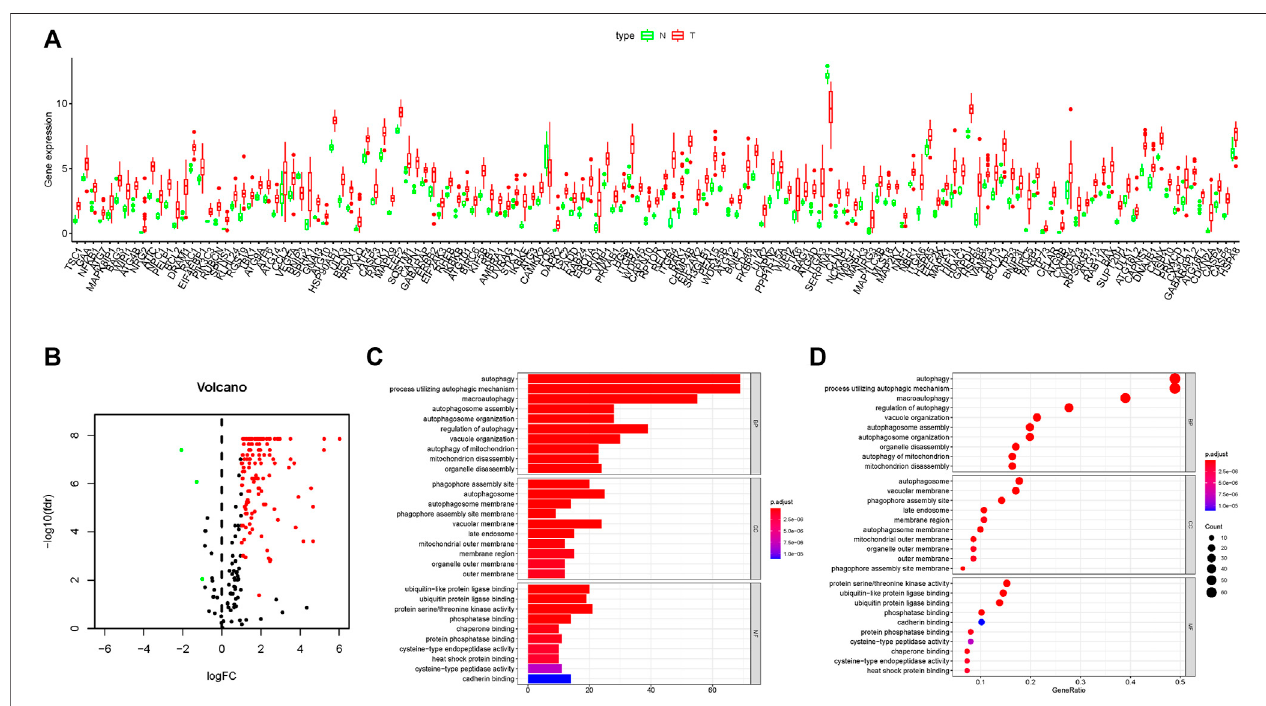
FIGURE 1 | Results of DEG expression pro fi les and enrichment analysis. (A – B) Box plot and volcano plot of differentially expressed autophagy-related genes in cholangiocarcinoma tissues. (C – D) Bar plot and bubble chart of relationship between differentially expressed genes and functional pathways in GO analysis.